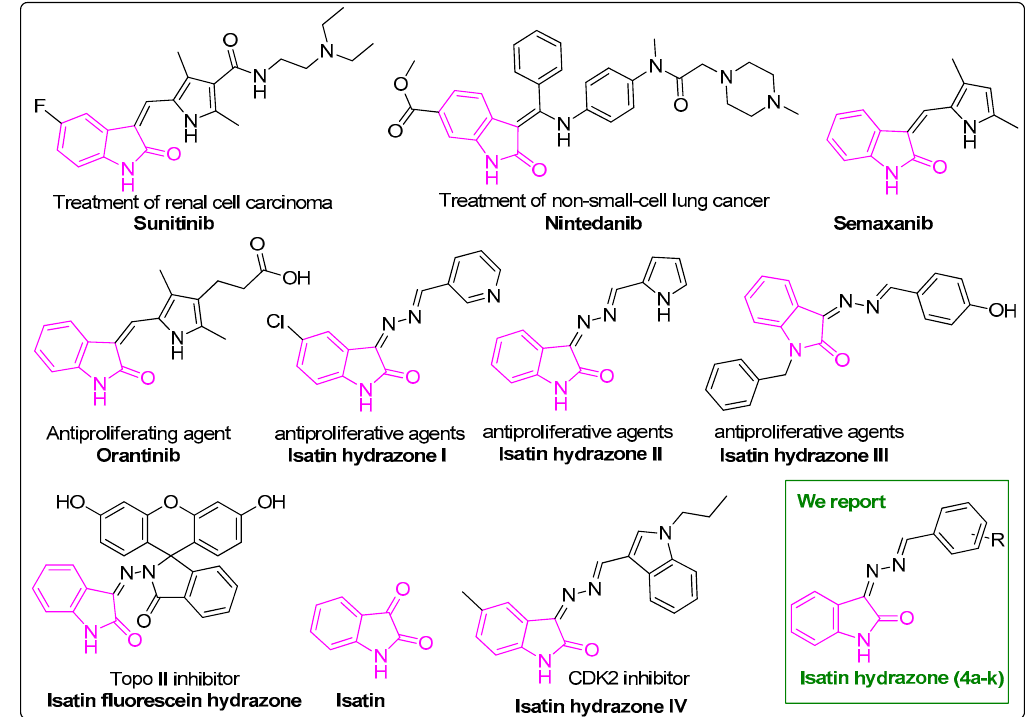
Figure 1. Isatin moiety containing active and potential